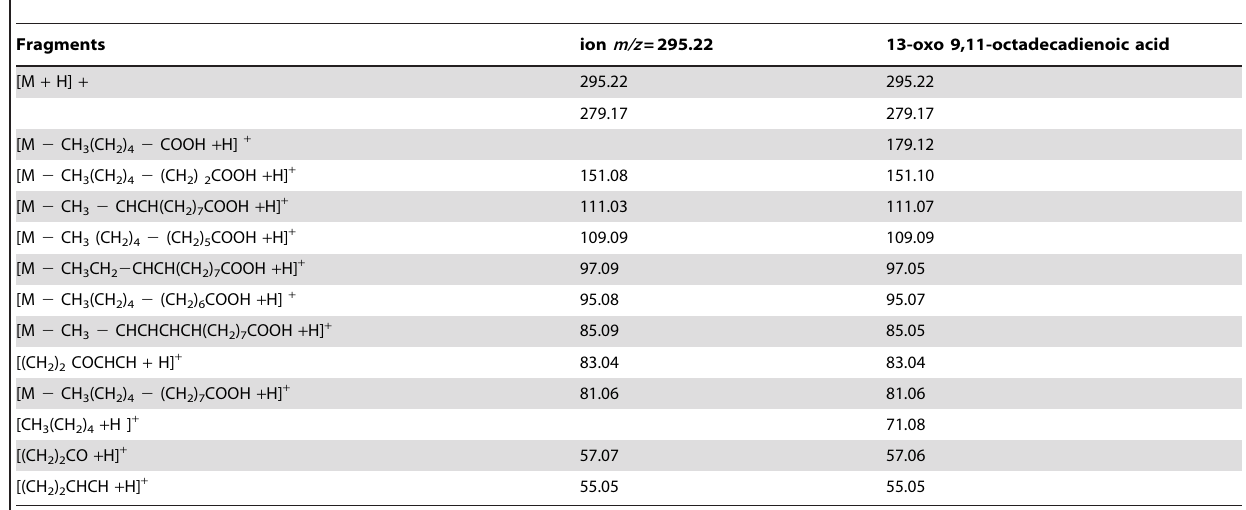
Table 2. Fragmentations of the positive ion ( m / z =295.22) identified as 13-oxo-9,11-octadecadienoic acid and of the commercial